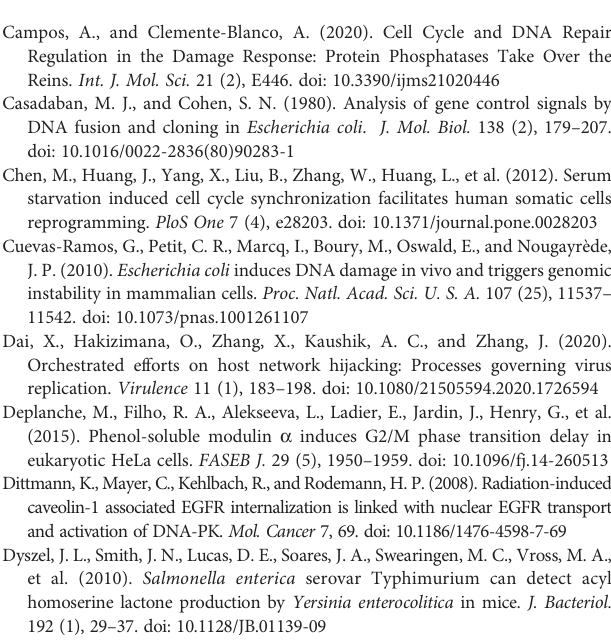
SUPPLEMENTARY FIGURE 2 | Illustration of the gating strategy to analyze the cell cycle of infected cells. HCT116 cells were infected with either MC-GFP or MC- RckGFP strain for 1 h at 37°C (MOI 100:1). At 6 h p.i., cells were lysed and stained with propidium iodide. Samples were analyzed by fl ow cytometry using a gating